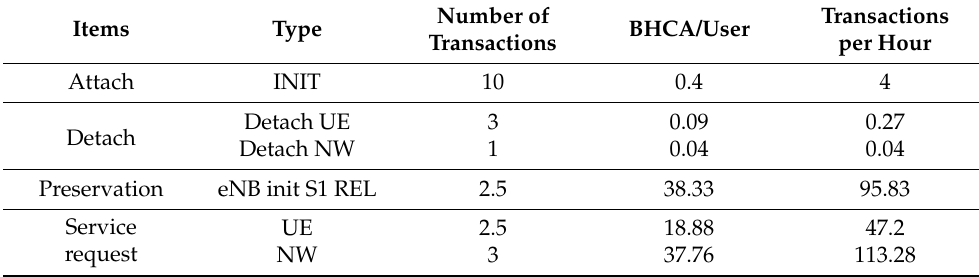
Table 2. MME call model: assuming 400,000 subscriber